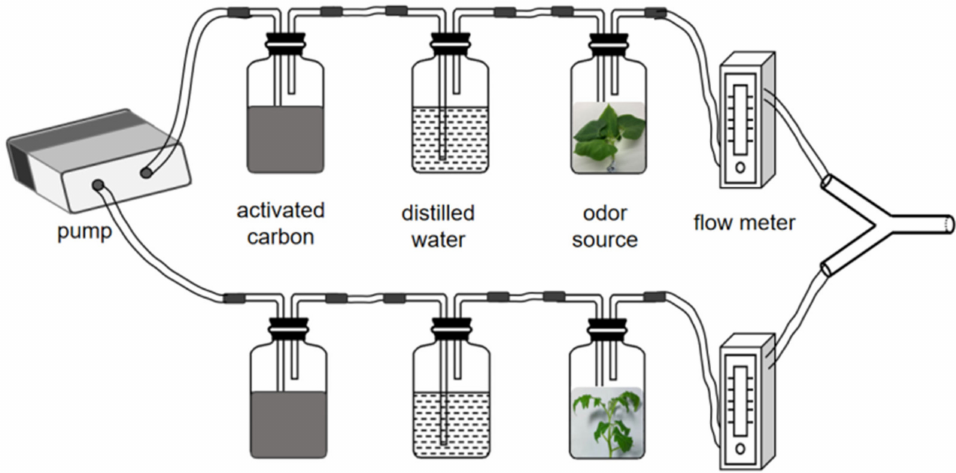
Figure 1. Schematic of the Y type olfactory